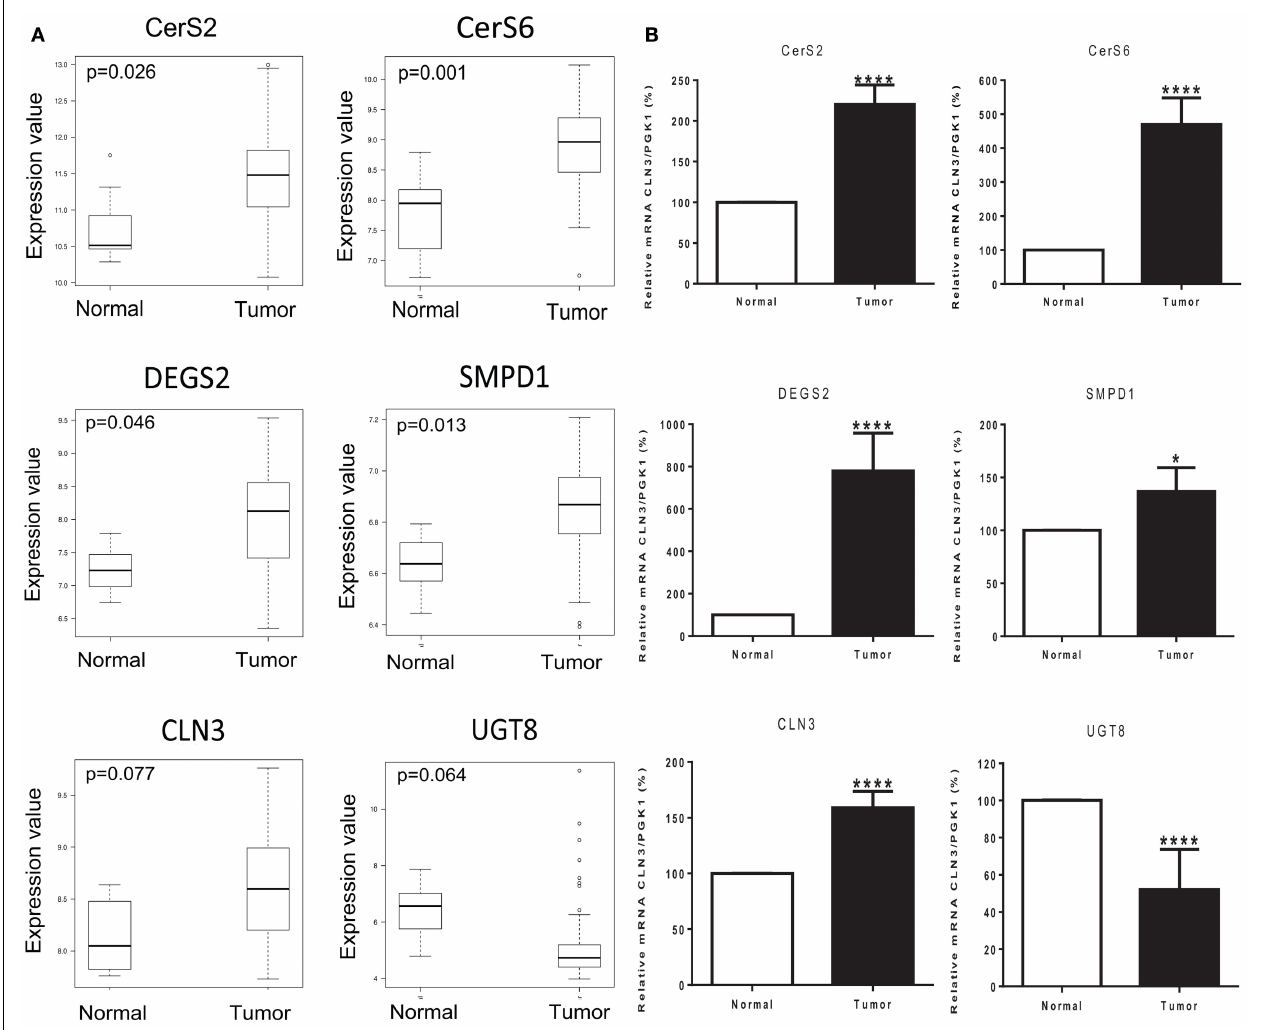
FIGURE 3 | Tumor status and expression of genes of interest . (A) Box plots of six genes of interest ( CerS2 , CerS6 , DEGS2 , SMPD1 , CLN3 , and UGT8 ) coding for enzymes involved in sphingolipid metabolism with differences in expression between normal and tumor tissue samples. The line in the middle of the boxplots represents the median in normal and tumor samples. * p < 0.05 was considered as statistically significant. (B) Relative mRNA expression was measured by RT-PCR. The following genes related to sphingolipid metabolism are ceramide synthase 2 ( CerS2 ), ceramide synthase 6 ( CerS6 ), delta(4)-desaturase sphingolipid 2 ( DEGS2